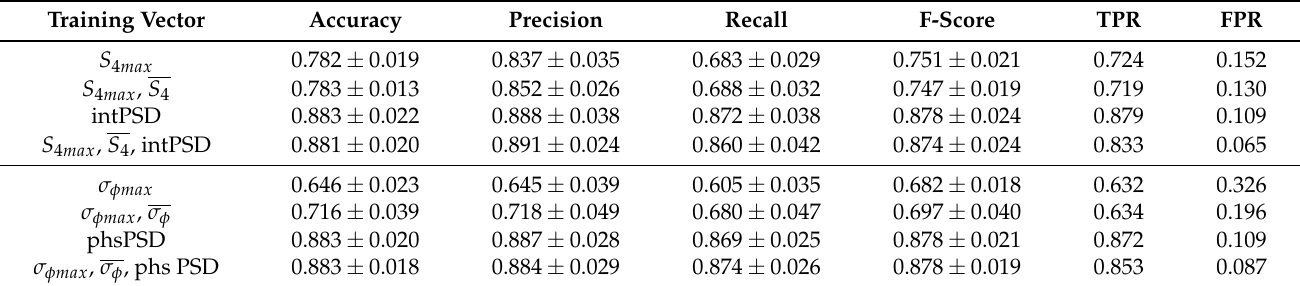
Table 3. Performance overview with optimised Gaussian kernel.